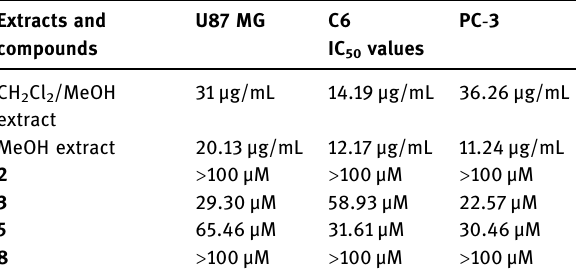
Table 3: Inhibitory concentration values of extracts and some compounds that kill or inhibit 50% of cancer cells ( IC 50 in µg/mL for extracts, and µM for compounds ) Extracts and